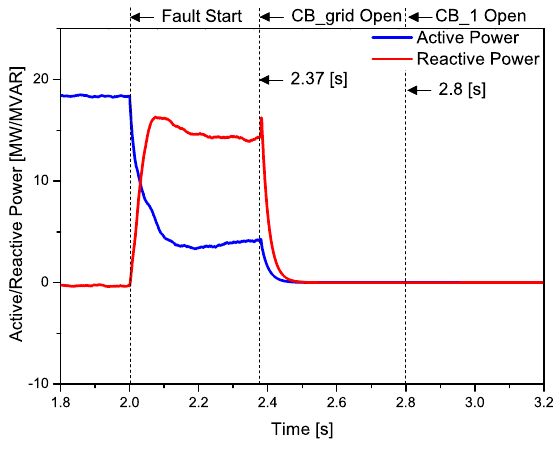
Figure 9. Offshore wind farm output without an SFCL.